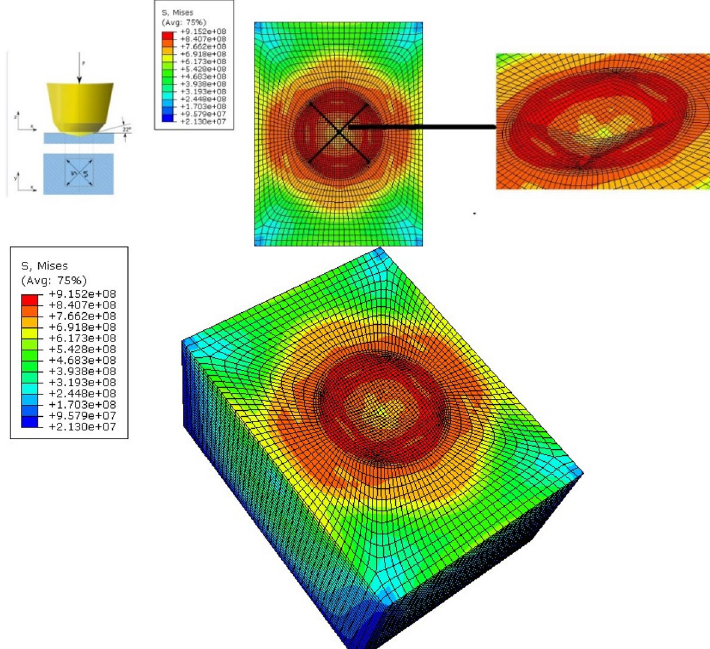
Figure 9. Modelling and simulation of the Vickers hardness